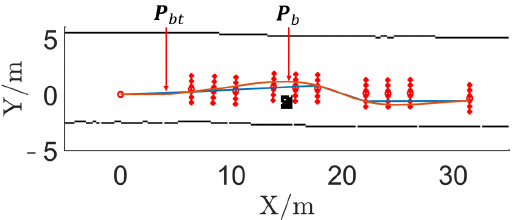
Figure 11. An example of smoothed